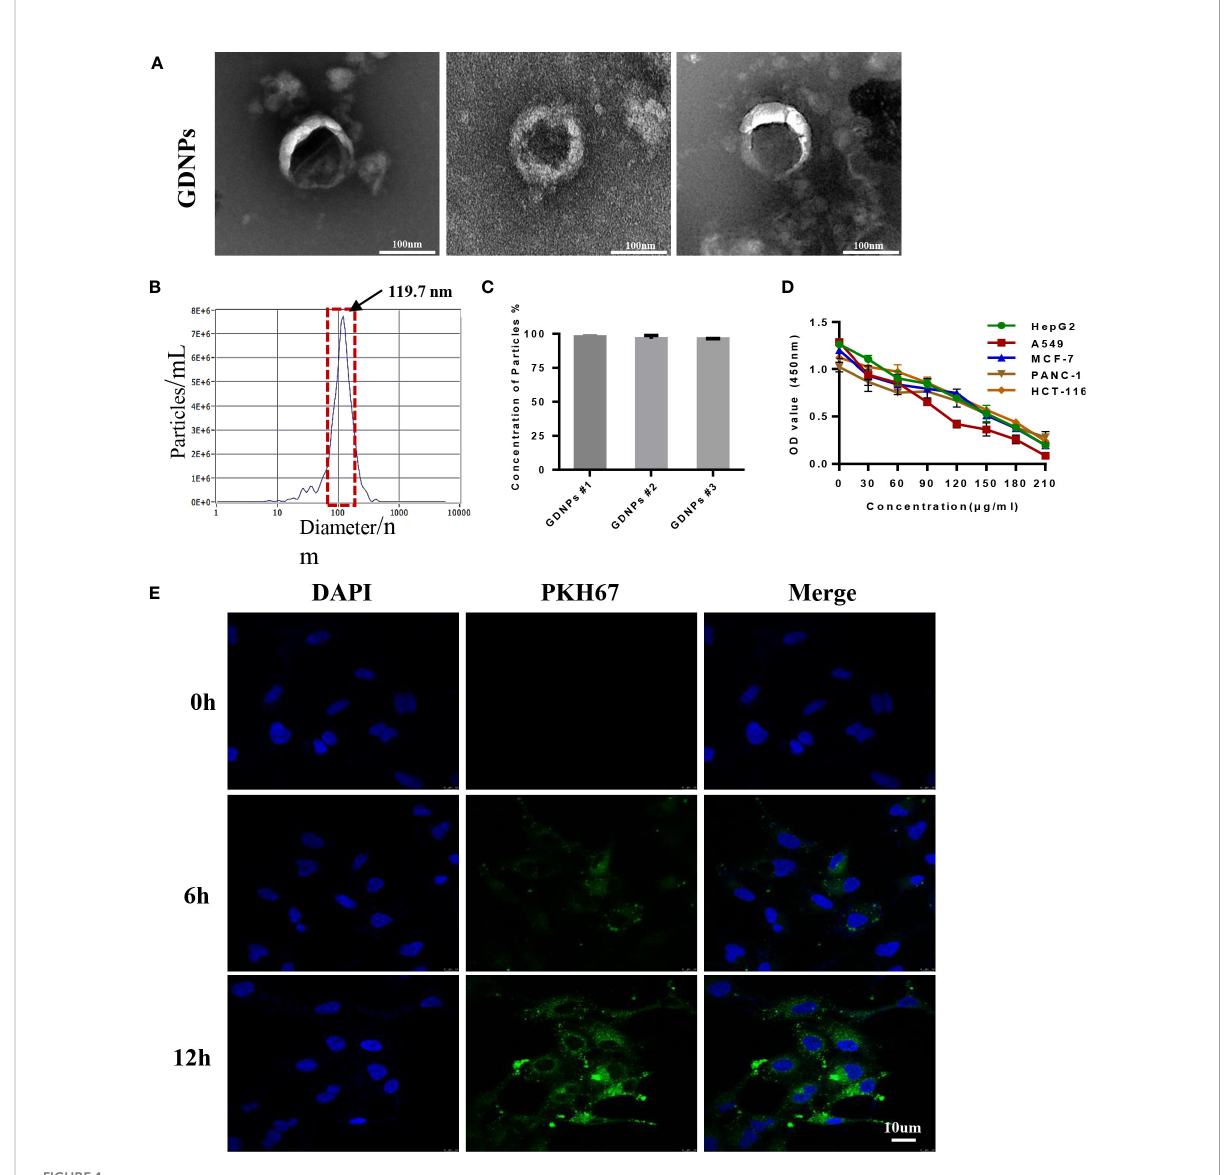
FIGURE 1 Characterization of nanoparticles derived from ginseng root. (A) The morphology of GDNPs was observed by TEM, scale bar = 100 nm (n = 3). (B) Nanoparticle tracking analysis (NTA)-based determination of GDNPs number and size distribution (n = 3). (C) GDNPs concentration expressed as percentage per batch (n = 3). (D) GDNPs effects on cell viability of HepG2, HCT-116, A549, PANC-1, and MCF-7 cells as analyzed via MTT assay. (E) Confocal microscopic image showing internalization of PKH-67-labeled GDPNs by A549 cells at indicated timepoints. Data are presented as the mean ± SD of three